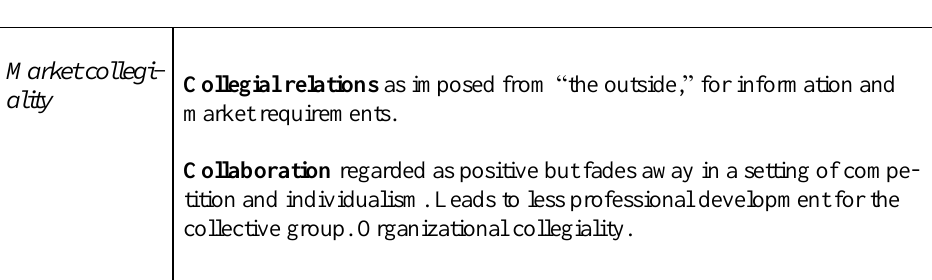
Collegiality as ideal types in the framework of institutional logics (Freidson, 2001) Ideal types of collegiality in terms of collegial relations and collaboration Market